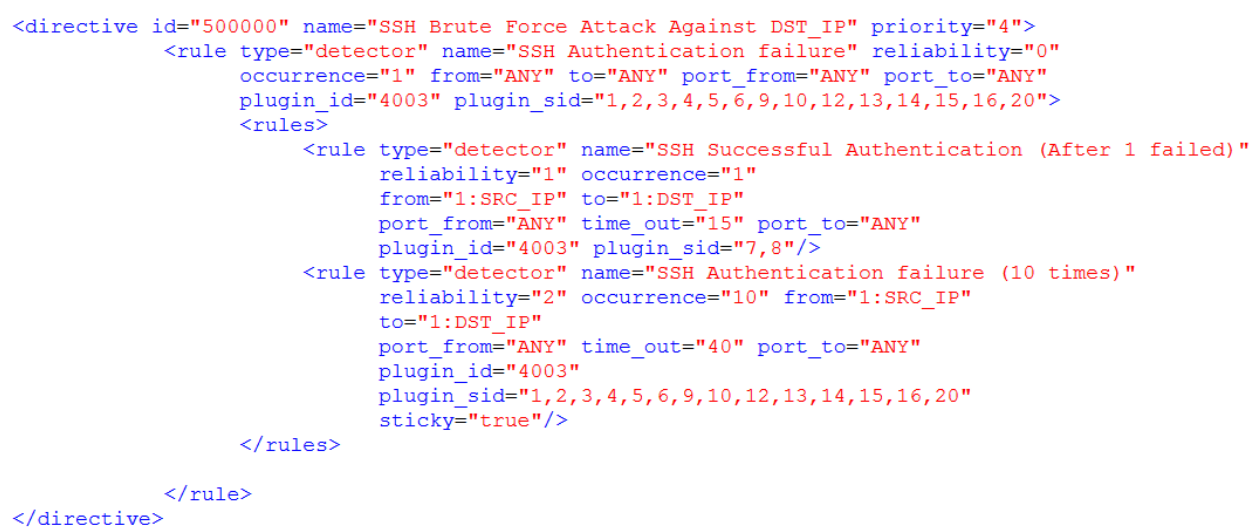
Figure 9. Example OSSIM correlation